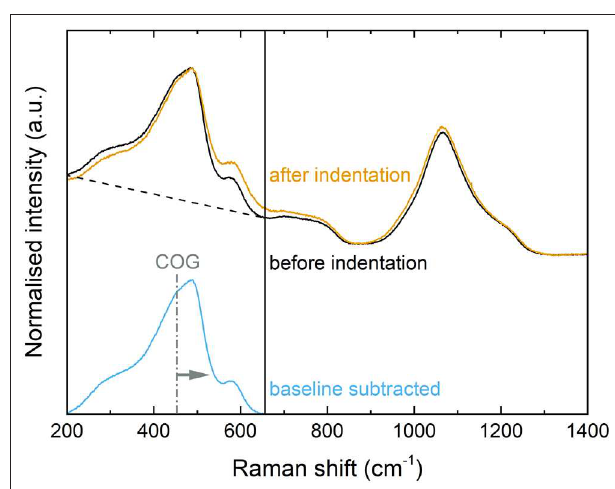
FIGURE 2 | Raman spectra of a glass before (black) and after (orange) densification by Vickers indentation. The blue spectrum shows the low frequency region after subtraction of a baseline (dashed black line) and was used to calculate that region’s center of gravity (COG, gray dash-dotted line). The densification shifted intensities in the low frequency region. This was quantified by determining the shift of the COG (arrow, not to scale).